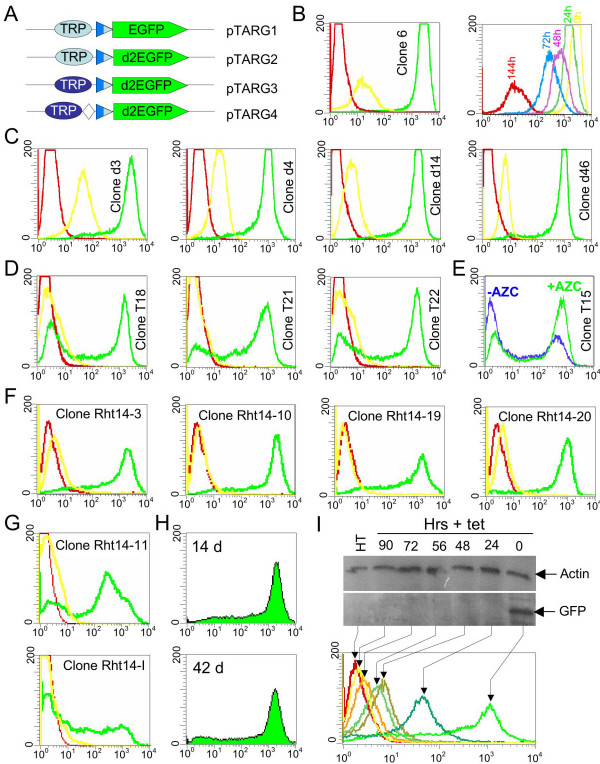
Screening for well-regulated GFP expression. A. Schematic (not to scale) of the target constructs used. DNA is represented as in Fig. 1. Pale and dark ellipses represent original and improved TRP, respectively. B-I. Flow cytometric profiles (y-axis, counts; x-axis, GFP fluorescence [FLH1]) of clones isolated after transfection with plasmids shown in A. For profiles in B (left only), C, D, F and G the green and yellow traces represent cells grown with or without tet, respectively, and the red traces represent GFP-negative cells (Rht14 or HT1080). B. Left: Clone 6, the most stringently regulated clone isolated after transfection of pTARG1 into HT2 cells. Right: GFP expression profile of Clone 6 at indicated times after addition of tet. C. Four of the most stringently regulated clones isolated after transfection of pTARG2 into HT2 cells. D. Three of the most stringently regulated clones isolated after transfection of pTARG3 into HT2 cells. E. Effect of AZC on GFP expression in T15, a pTARG3-transfected HT2 clone. Cells were cultured with (green) or without (blue) AZC for 24 h, and then for a further 24 h without AZC, before analysis. F. Four of the most stringently regulated clones isolated after transfection of pTARG4 into Rht14 cells. G. GFP expression profile of two heterogeneously expressing clones isolated after transfection of Rht14 with pTARG4. H. Profile of clone Rht14-10 grown continuously with passaging for 14 d or 42 d. I. GFP expression in clone Rht14-19, as measured by immunoblot (top) or flow cytometry (bottom), at the indicated times after addition of tet.